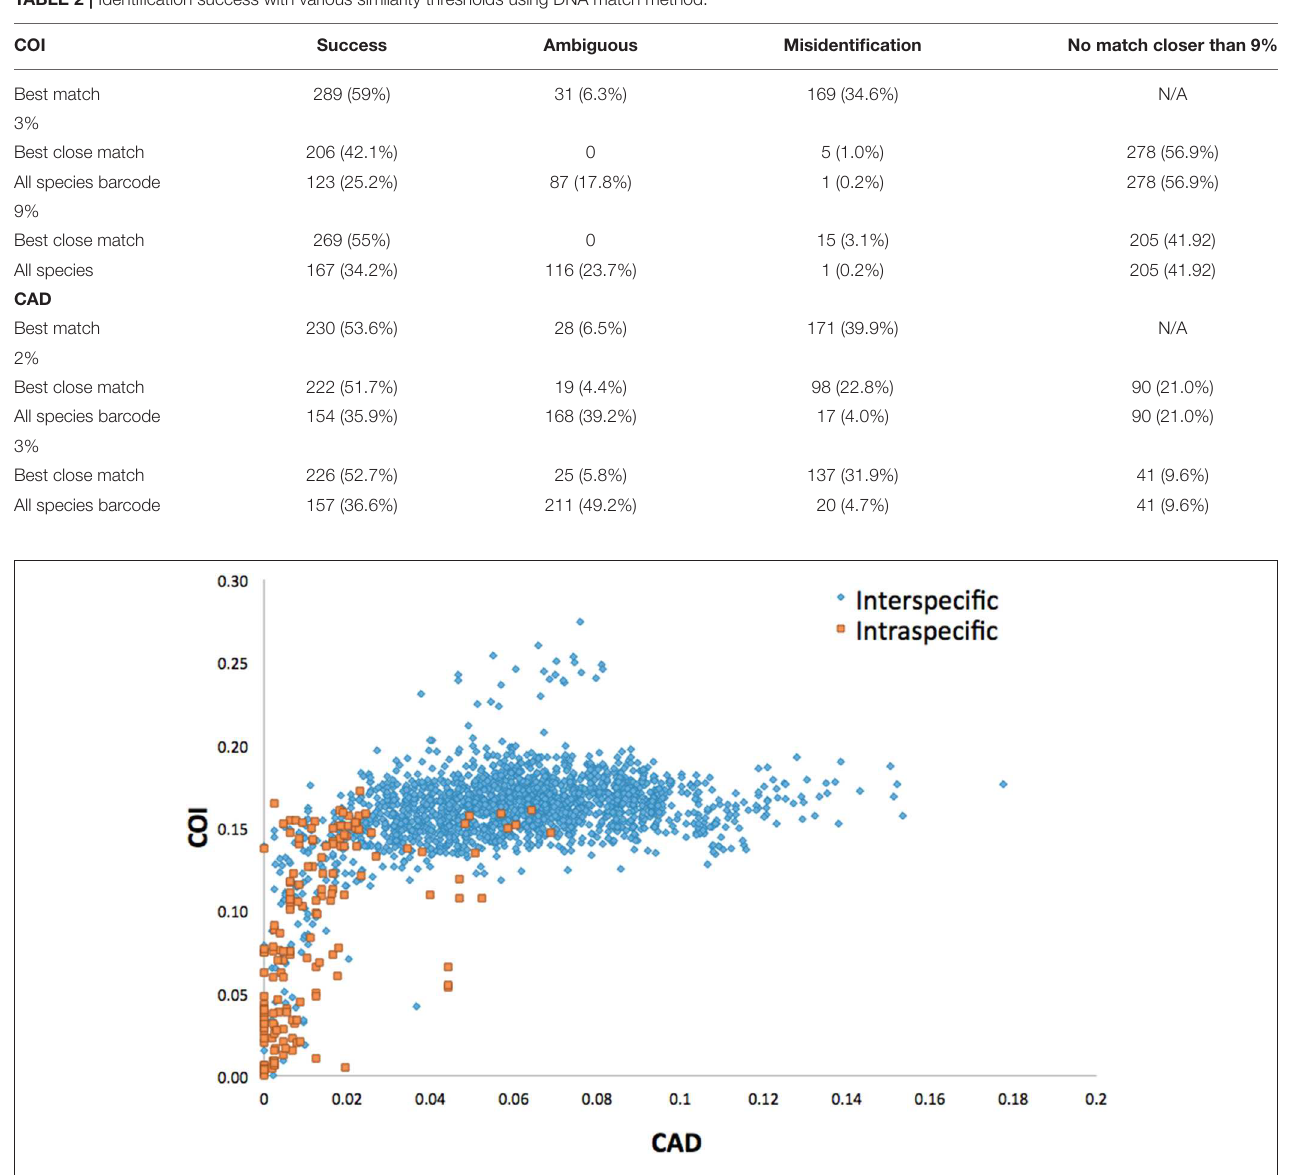
FIGURE 1 | Pairwise uncorrected “ p ” intra- and interspecific distances for COI and